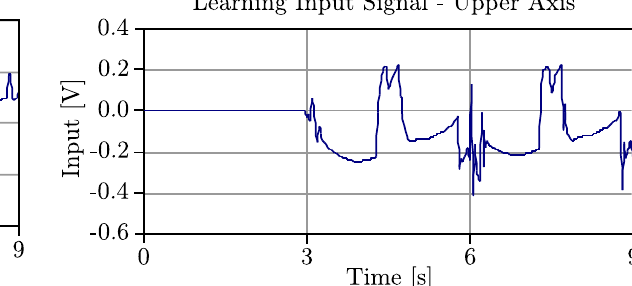
Figure 6: Learned feedforward signal - lower axis